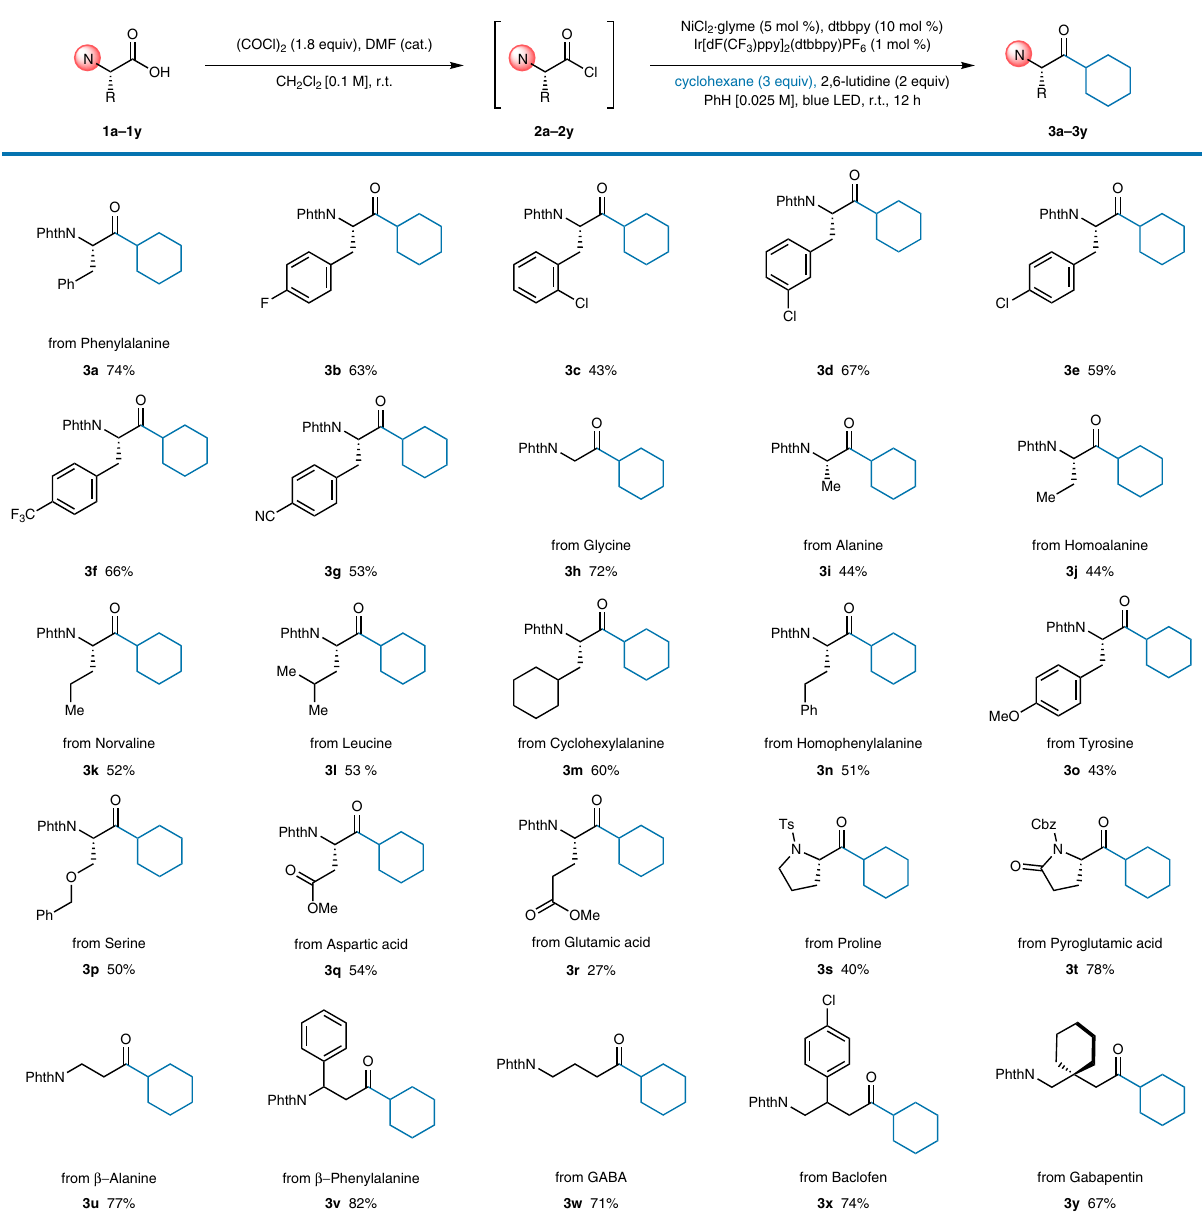
Fig.2|Aminoacidscope. Reactionconditions: 1a – 1y (0.20mmol),oxalylchloride (1.8 equiv), DMF (cat., 0.2 μ L), and CH 2 Cl 2 (2.0mL). After evaporation of the remaining solvent, NiCl 2 ·glyme (5mol %), dtbbpy (10mol %), 2,6-lutidine (2.0